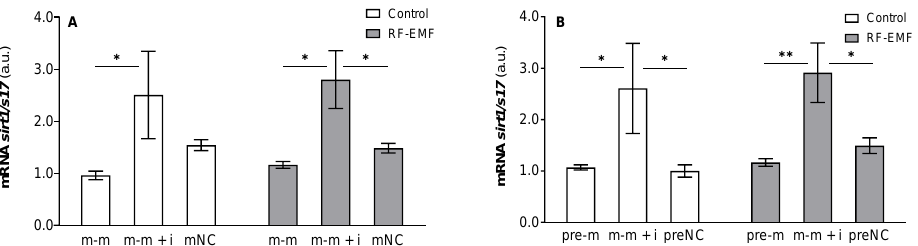
Figure 7. Effect of miR-34a administration on sirt1 ( sirtuin 1 ) mRNA expression in DLD1 cells under control and RF-EMF conditions. Cells were transfected with ( A ) miR-34a-5p (m-m), ( B ) pre-miR-34a (pre-m), mimic of mature miR-34a together with the miR-34a inhibitor (m-m + i) or corresponding negative control of mature and pre-miRNA (mNC and preNC, respectively). The data were relativised to the corresponding negative control measured under control conditions and presented as the mean ± SEM (n = 4). a.u.—arbitrary units. Two-way ANOVA, Tukey’s post hoc test, * p < 0.05, ** p < 0.01.